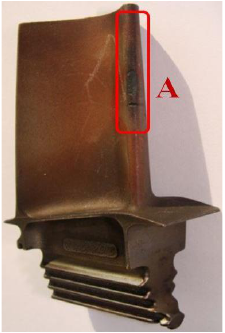
Figure 2. Blade from the rotor wreath of a high-pressure turbine, with a marked zone (A) of gas corrosion damage and crack damage of the leading edge of the blade.